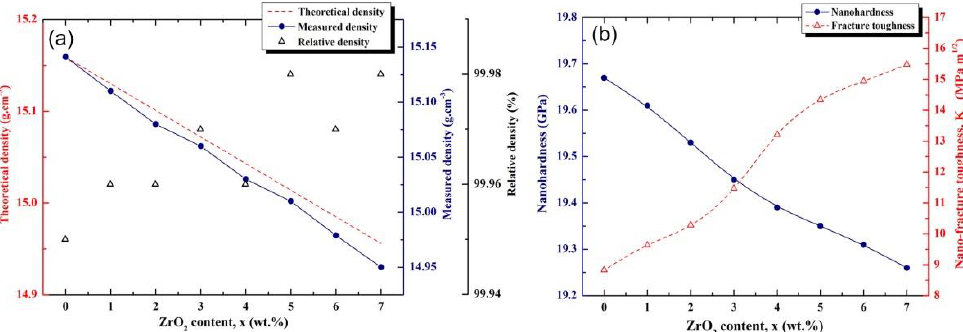
Figure 28. ( a ) Theoretical (broken line), measured (closed symbols), and relative densities (open symbols) of bulk 93(93-WC/7 wt. % (10Co/4Cr)) mixed with various ZrO 2 concentrations, x. The relationship between nanohardness and fracture toughness and the ZrO 2 concentration in bulk nanocomposite materials 100-x(93-WC/7(10Co/4Cr))/x ZrO 2 is shown in ( b ).